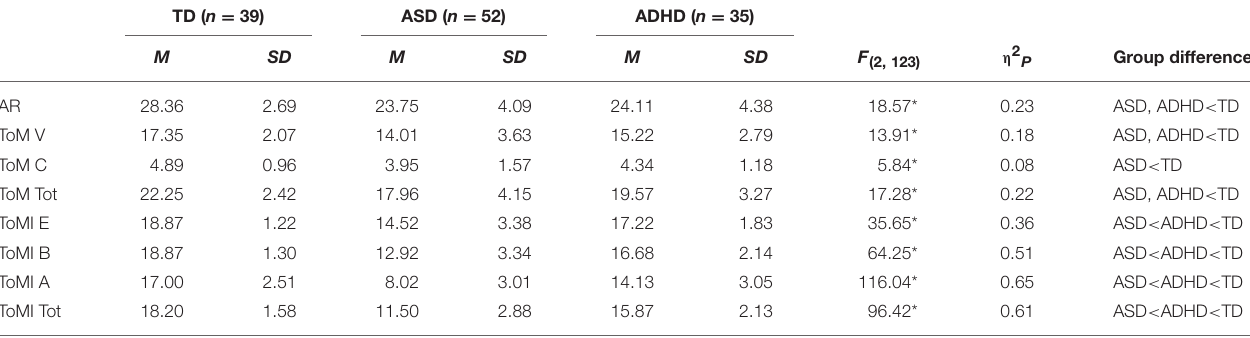
TABLE 2 | Differences between children with ASD, ADHD, and TD on ToM tasks and ToMI Inventory (ANOVAs). TD ( n = 39) ASD ( n = 52) ADHD ( n = 35) M SD M SD M SD F (2, 123) η 2 P Group differences